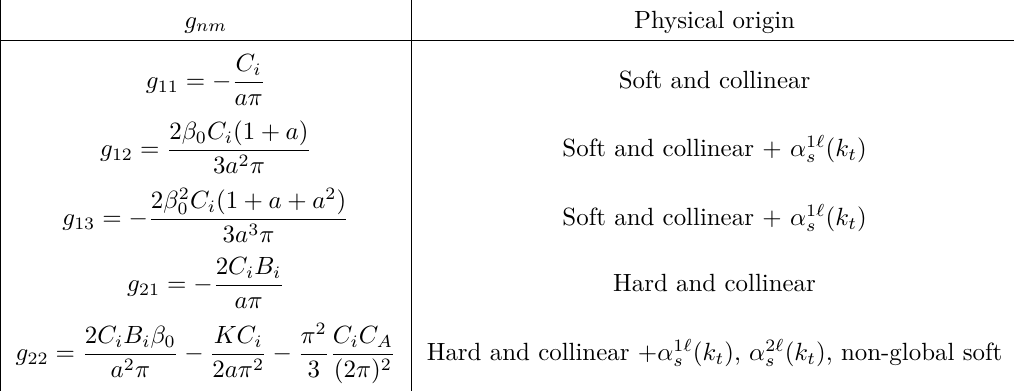
Table 1 . Relevant coefficients for the Sudakov form factor at N 2 DL